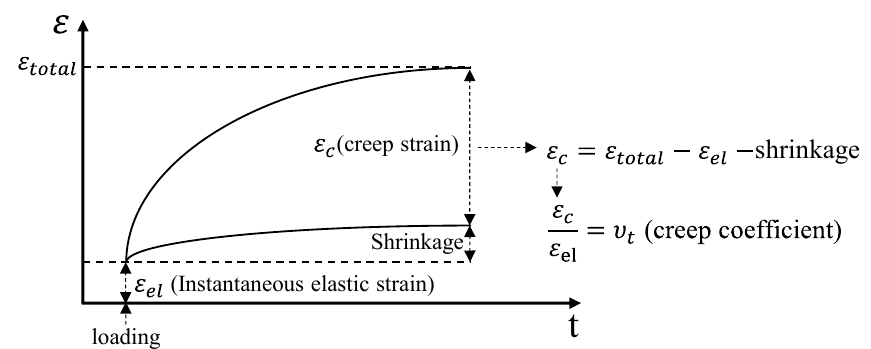
Figure 4. Concept of creep strain under load and creep coefficient.